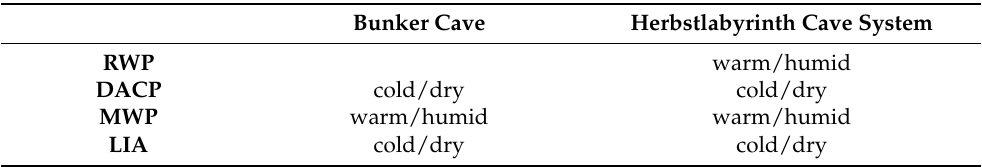
Table 4. Summary of the climate conditions at the two studied cave sites during the cold (Dark Ages Cold Period (DACP) and Little Ice Age (LIA)) and warm phases (Roman Warm Period (RWP) and Medieval Warm Period (MWP)). Bunker Cave Herbstlabyrinth Cave System RWP warm/humid DACP cold/dry cold/dry MWP warm/humid warm/humid LIA cold/dry